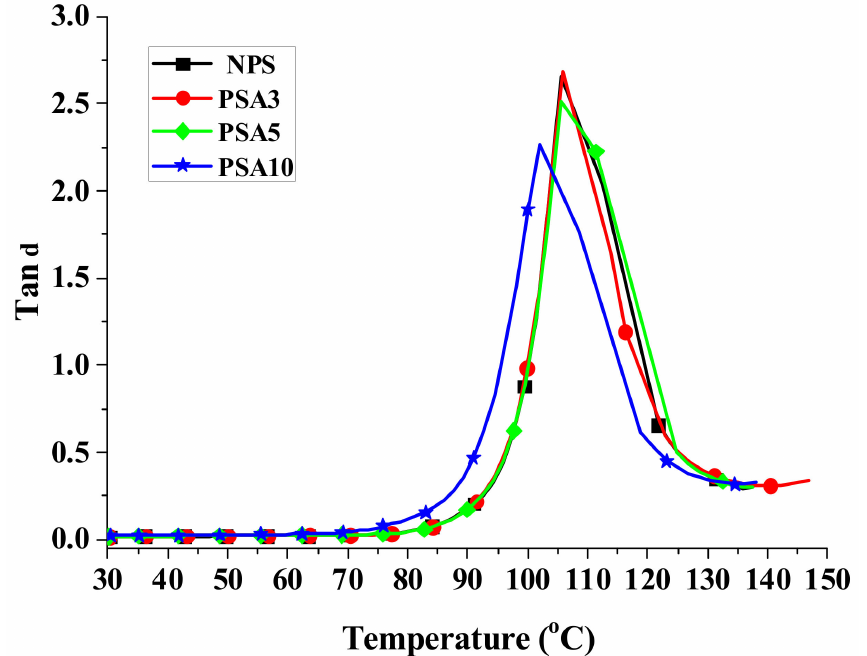
Figure 6. The measured loss tangent of Type I samples with respect to the temperature